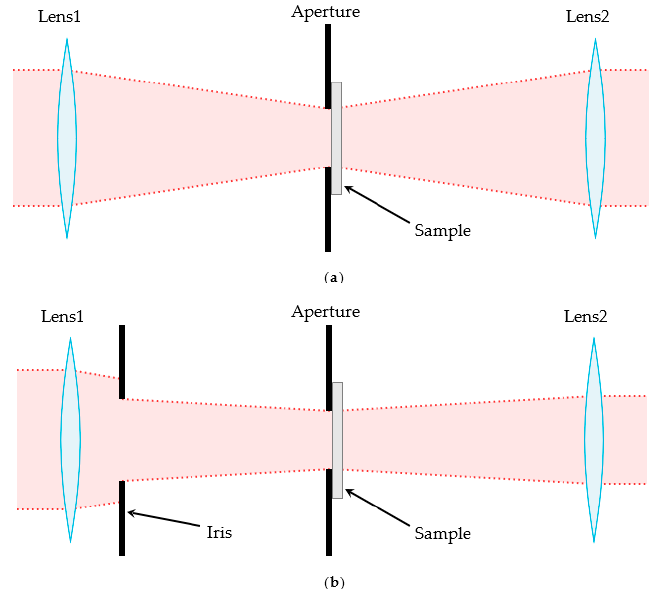
Figure 2. A comparison of the incident ray bundles during unrestricted FTIR analysis ( a ) and restricted FTIR analysis ( b ).